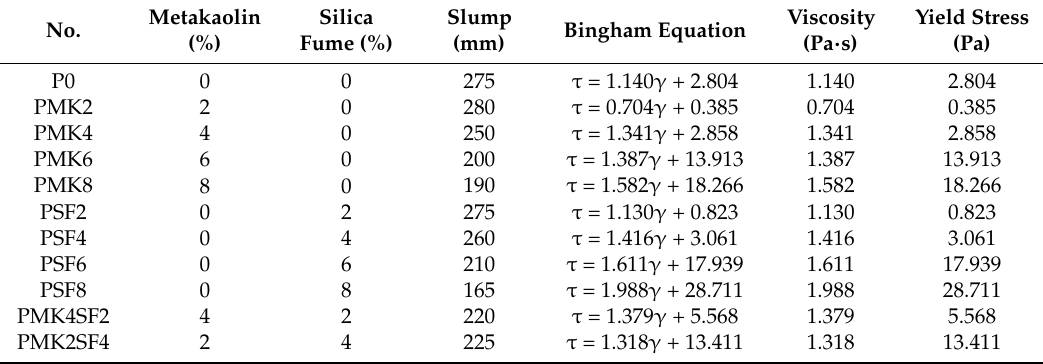
Table 4. Effect of Silica Fume (SF) and Metakaolin (MK) on the rheology of